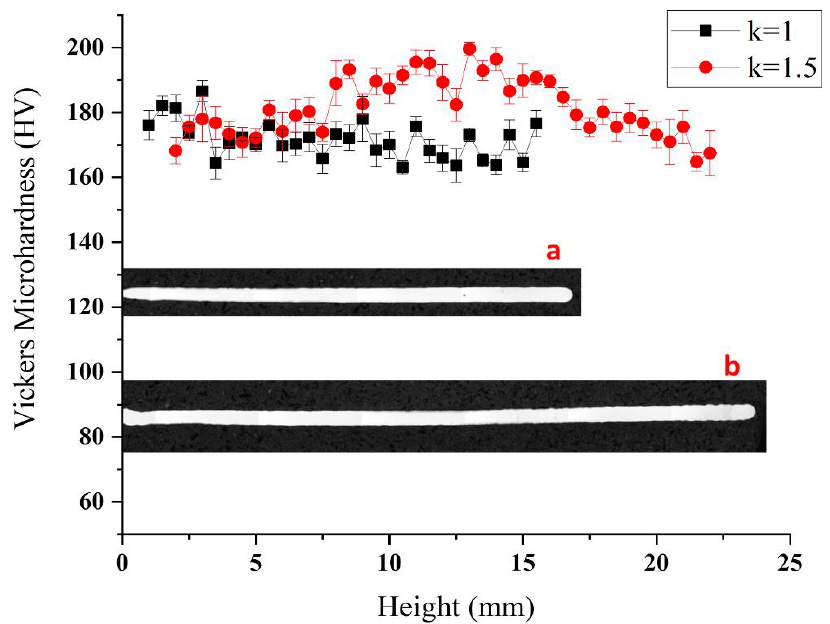
Figure 8. Hardness distribution at different heights of thin-walled parts with different K . Section of thin-walled part at ( a ) K = 1 and ( b ) K = 1.5.